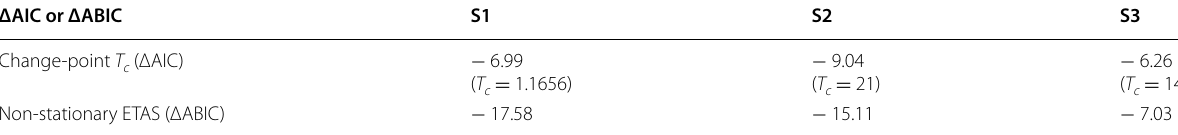
Table 7 Model comparisons between the two-stage ETAS model and the non-stationary ETAS model